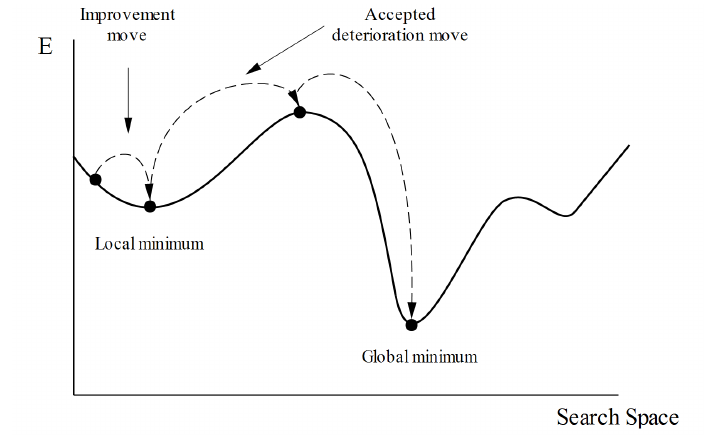
Figure 2 – Trajectory of simulated annealing